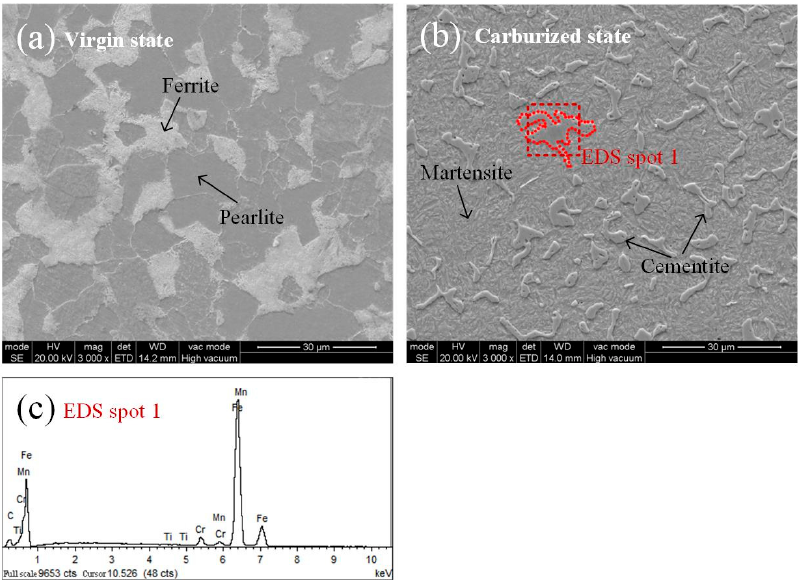
Figure 3. The SEM microstructures of 20CrMnTi steel: ( a ) virgin state, ( b ) carburized state; and ( c ) EDS result of cementites.